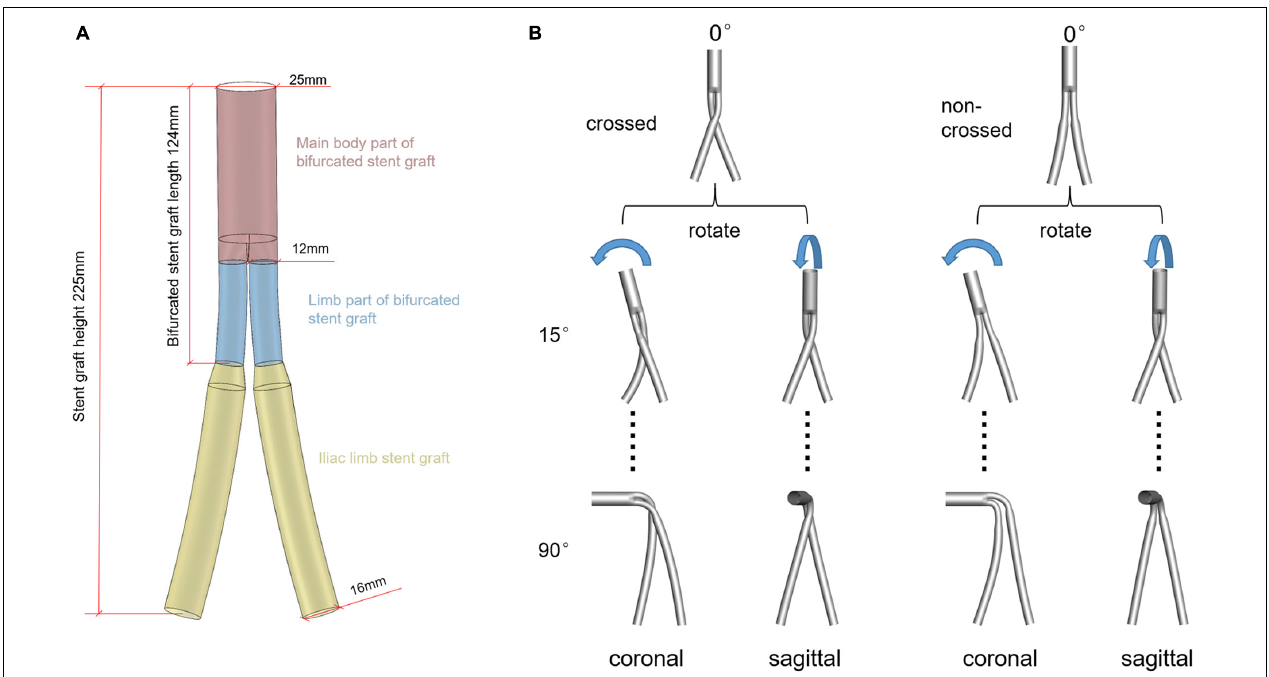
FIGURE 1 | (A) Schematic diagram of the 0 ◦ model. Different colors represent different parts of the SG system. (B) Schematic diagram of the establishment of ideal models, rotating the aneurysm neck in plane and space position under the control of the overall model height unchanged. The first line is the model schematic diagram of the aneurysm neck without angulation. The second and third lines represent the model schematic diagram with an angle of 15 ◦ and 90 ◦ after the rotation of the aneurysm neck, respectively. The rest of the aneurysmal neck rotated 30 ◦ , 45 ◦ , 60 ◦ , and 75 ◦ , respectively, with 26 models.